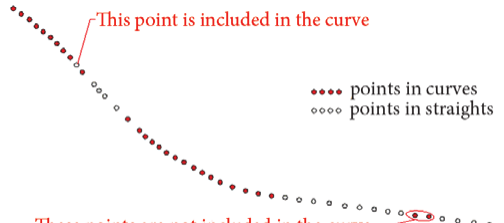
Fig. 6. Two example cases of corrections of segmentation into curves and straight segments